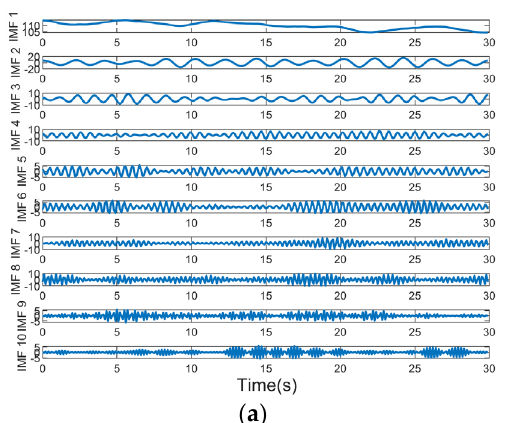
Figure 8. DA convergence curve for VMD parameter optimization.